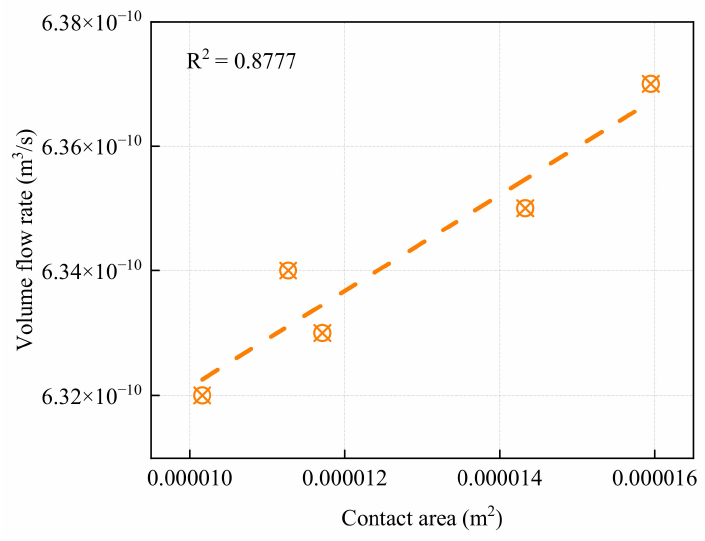
Figure 13. Effect of the microchannel contact area on the volume flow rate: data for cases with 64 pixel 2 (0.2273 mm 2 ) microchannel. Table 6. Volume flow rate through cement–rock sample: comparison of the base case (no microchan-